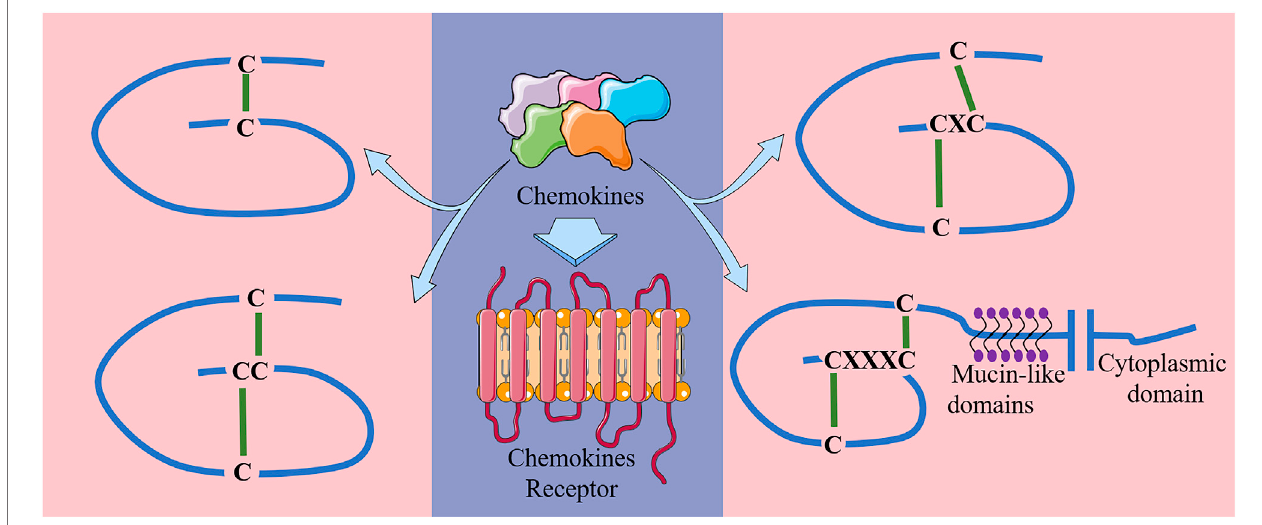
FIGURE 1 | Main structures of the four classes of